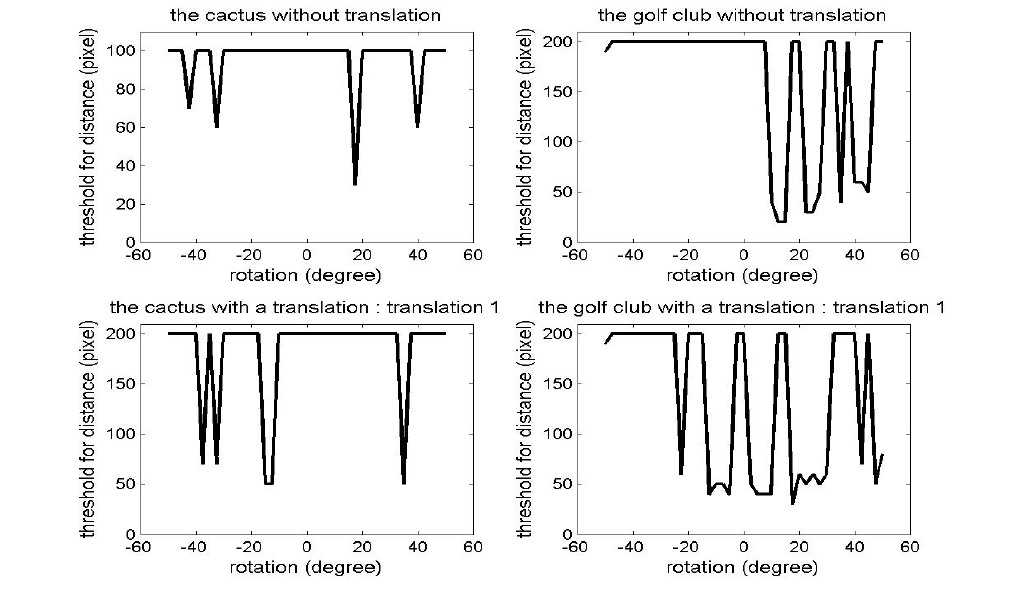
0  iter T for the convergence region tests in Section Figure 7. cedis tan